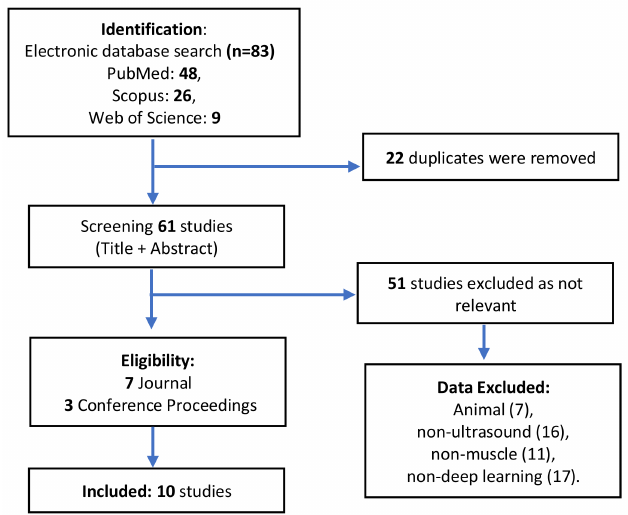
Figure 2. A review of deep learning in muscle ultrasound